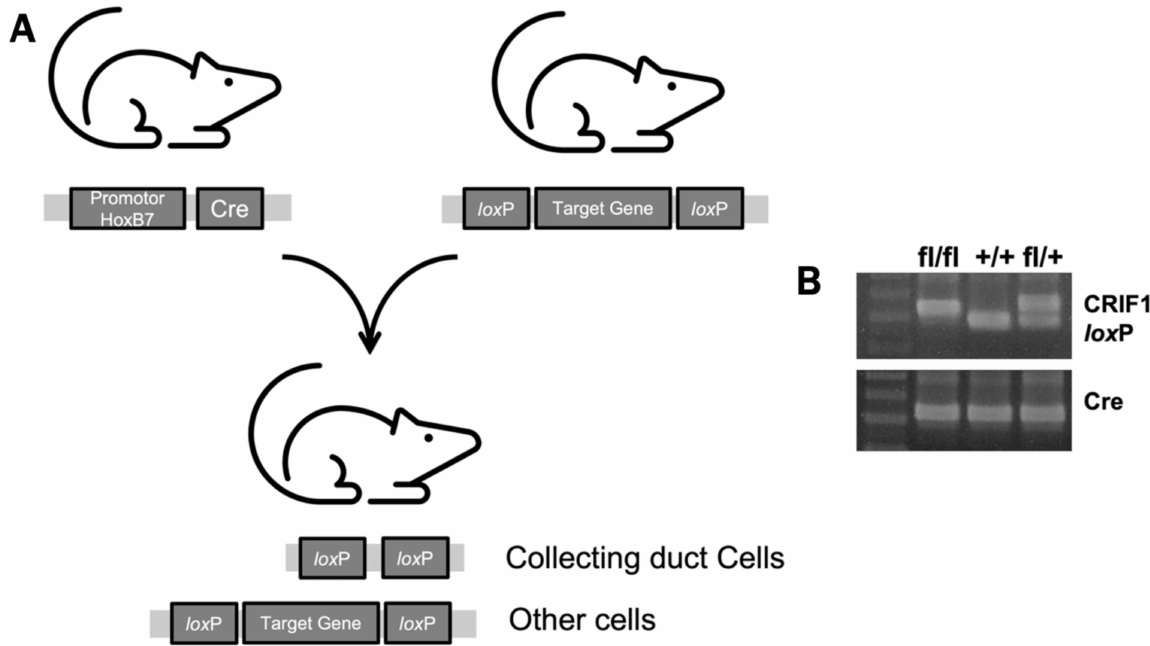
Figure 9. Generation of CR6-interacting factor-1 knockout (CRIF1-KO) mice. After CRIF1 flox/flox mice bred with HoxB7 mice ( A ), the genotype of siblings was evaluated using polymerase chain reaction ( B